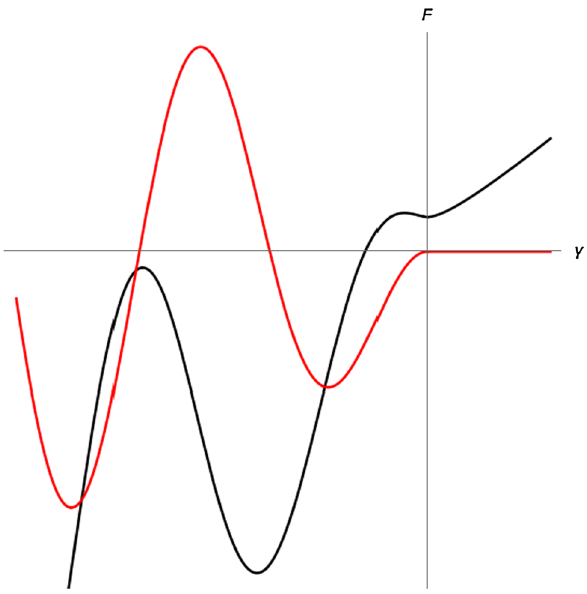
Fig. 1 F as a function of γ , and for a fixed x (cid:12) − x ; the black curve represents the real part; the red curve corresponds to the conventional imaginary part. Both curves are continuous in the full real interval